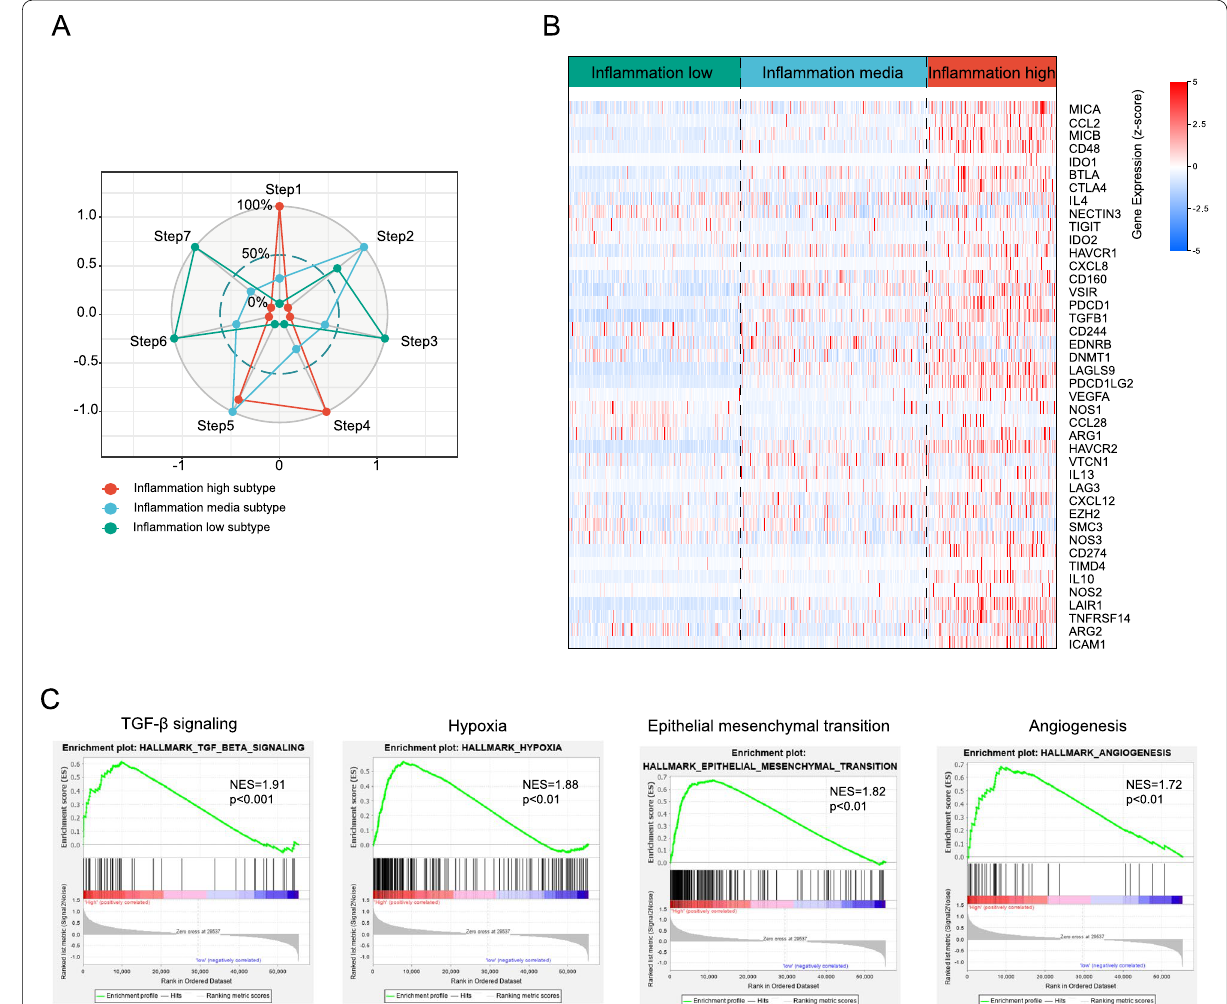
Fig. 4 Estimation of anticancer immune activity among inflammation subtypes. A Anticancer immune activity of the seven-step cancer-immunity cycle. B Heatmap presenting genes expression involved in the negative regulation of the immune processes. C GSEA analysis reveals the underlying biological processes correlated with inflammation